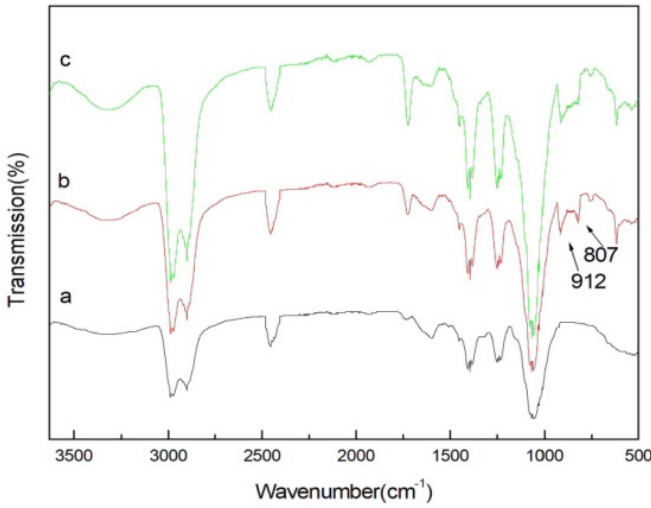
Figure 2. FTIR spectrum of loofah ( a ), loofah − g − GMA ( b ), and MML ( c ). (Note: the arrows point to the position of characteristic peak).